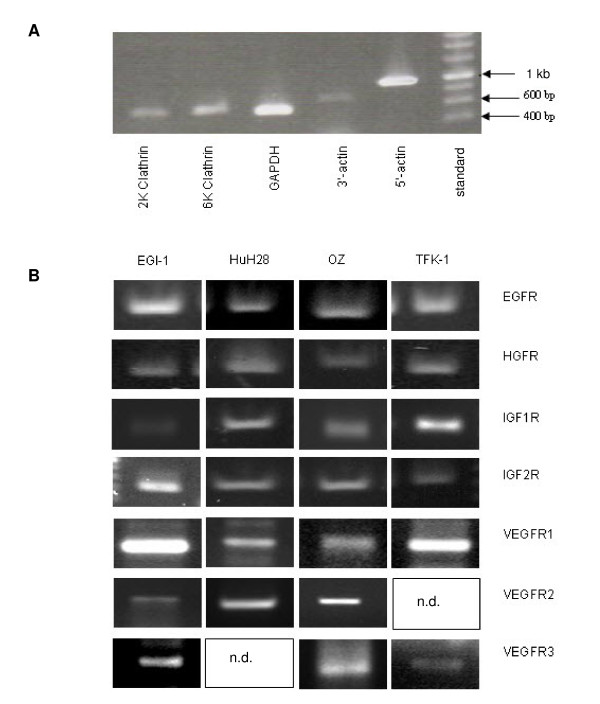
RT-PCR for housekeeping genes and growth factor receptors. A) PCR analysis to ensue the presence and integrity of five housekeeping genes from TFK-1, representative for all cell lines used. B) mRNA expression of growth factor receptors in four CC cell lines (n. d. = not detected).